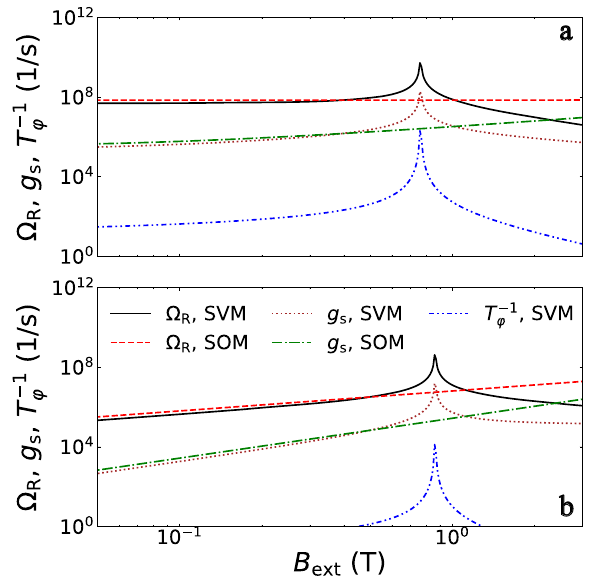
Fig. 2 Rabi frequencies and spin pure dephasing. Rabi frequency